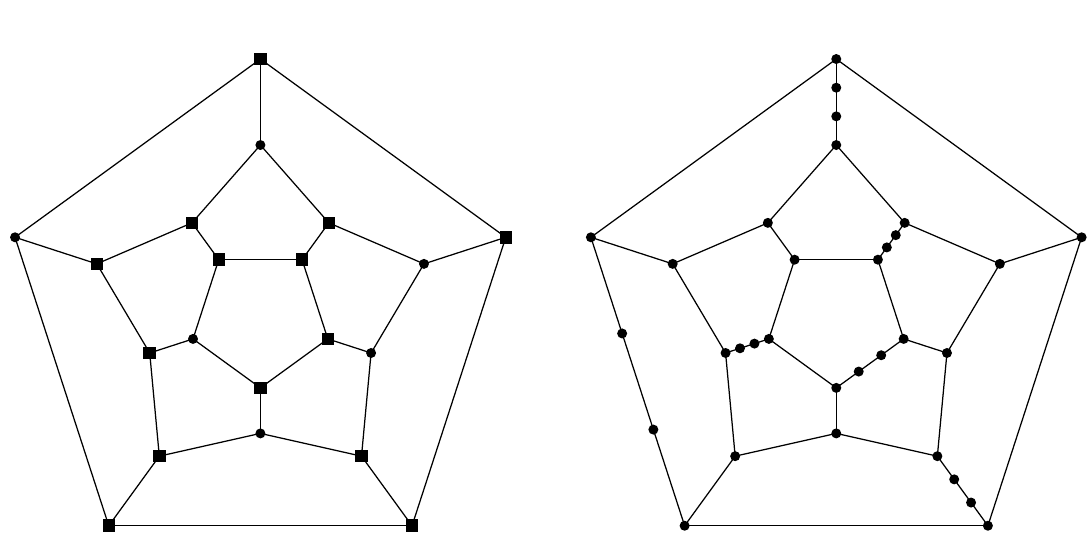
Fig. 1: The dodecahedron with 14 square vertices that induce a forest, and the graph D 2